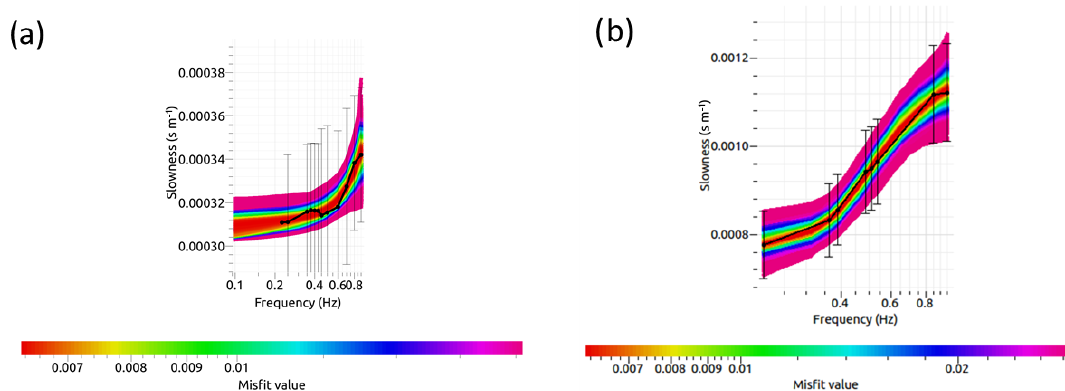
Figure 13. Results of inversion of averaged dispersion curves for station pairs of Group 1 (a) and Group 2 (b) . The plots demonstrate the fit of model dispersion curves to the observed dispersion curve marked by the solid black line with the corresponding error bar. An ensemble of all models that equally fits the data and prior information is shown by colour plots, in which the colour scale indicates the value of misfit function.